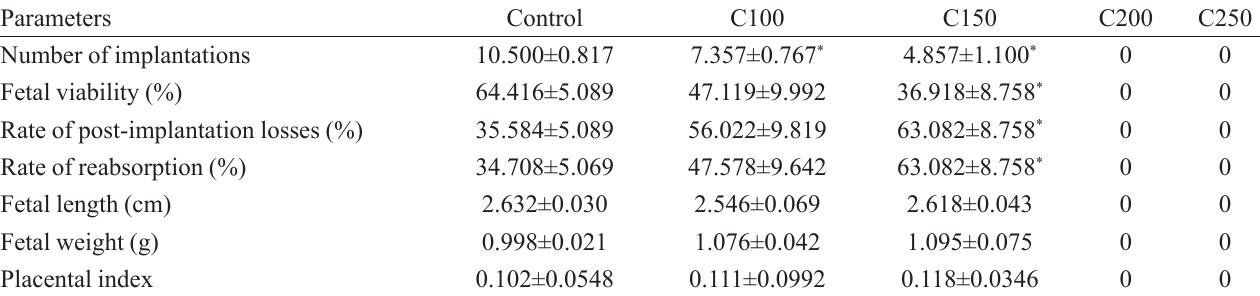
TABLE - II – Evaluation of parameters related to fetal development of male mice offspring treated with cyclophosphamide Parameters